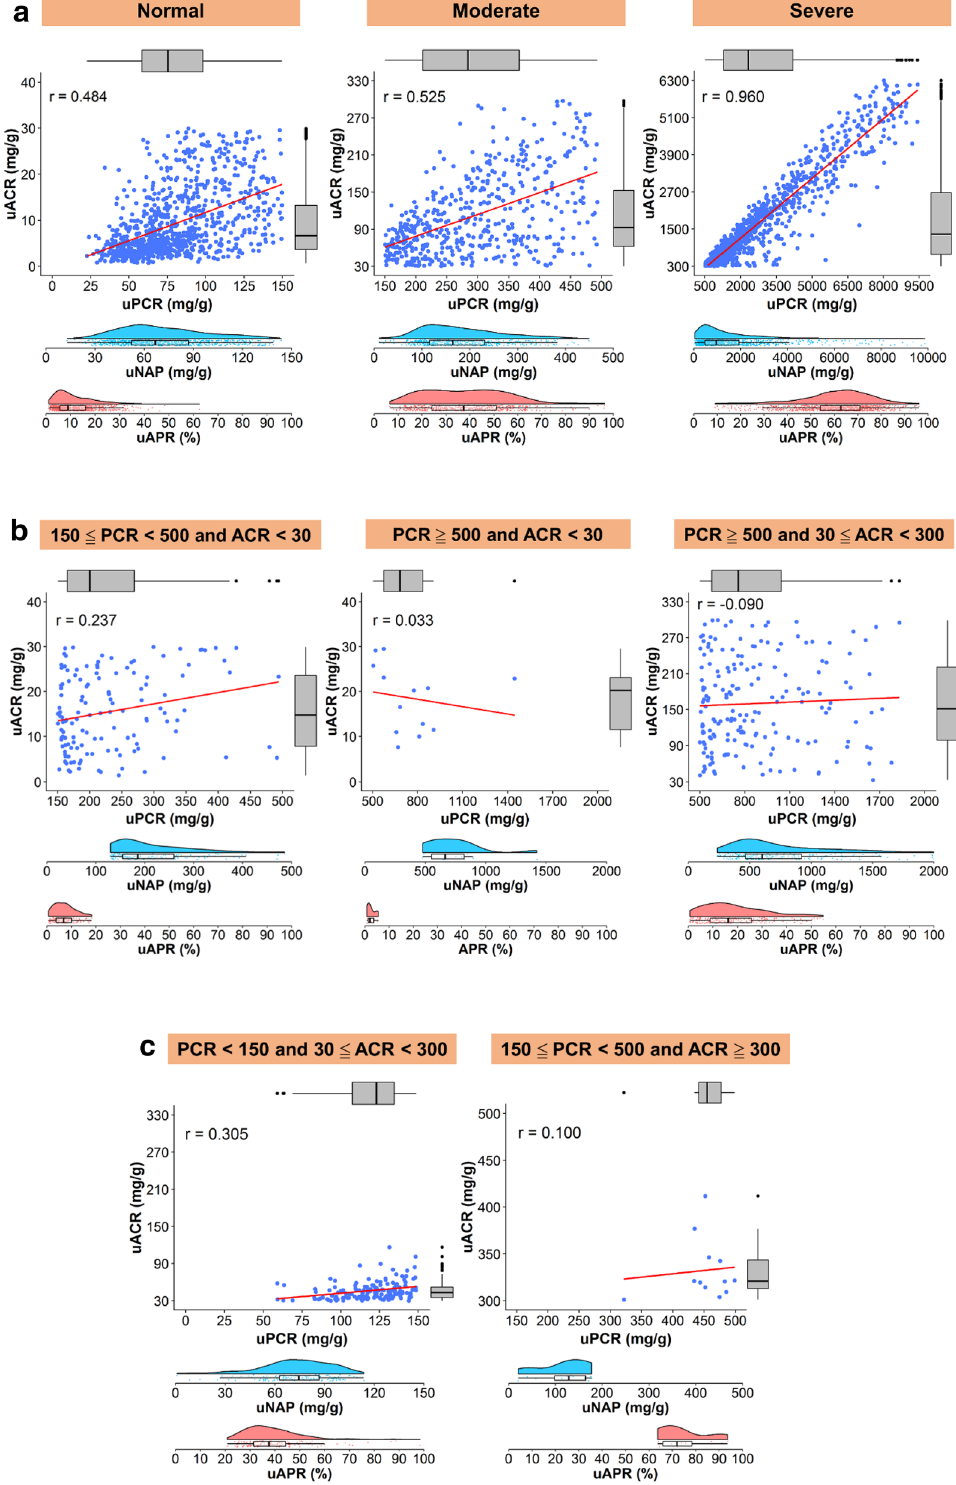
Figure 1. ( a ) The correlation between uPCR and uACR based on the severity grade of concordant proteinuria. The distribution of uAPR and uNAP is shown using a raincloud plot that combines a boxplot, raw jittered data, and the probability density curve. r , Pearson correlation. ( b ) The correlation between uPCR and uACR based on different categories of non- albumin predominant proteinuria. The distribution of uAPR and uNAP is shown using a raincloud plot that combines a boxplot, raw jittered data, and the probability density curve. r , Pearson correlation. ( c ) The correlation between uPCR and uACR by the albumin predominant proteinuria between uPCR and uACR. Numbers along the box plot refer to the median and interquartile range. The distribution of uAPR and uNAP are shown using a raincloud plot that combines a boxplot, raw jittered data, and the probability density curve. r , Pearson